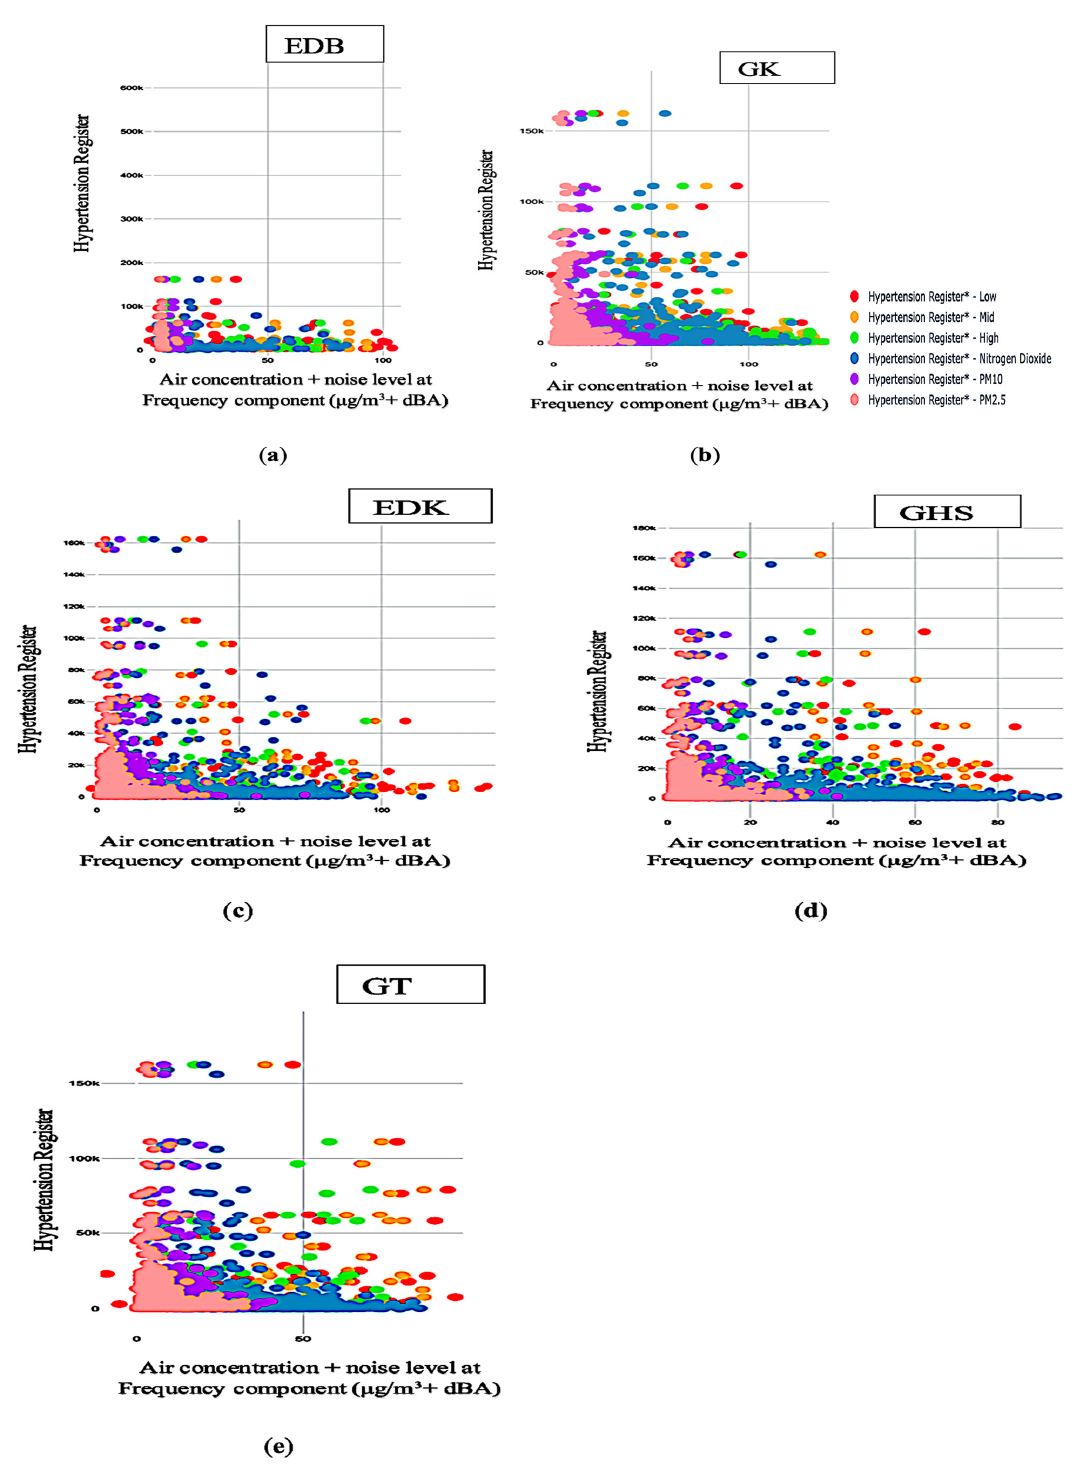
Figure 3. Relationship between joint air concentration and noise level at different frequency com- ponent range and registered hypertension cases at the five monitoring sites: ( a ) Joint air-noise pollution (dBA)/( µ g/m 3 ) with registered hypertension cases at EDB; ( b ) Joint air-noise pollution (dBA)/( µ g/m 3 ) with registered hypertension cases at GK; ( c ) Joint air-noise pollution (dBA)/( µ g/m 3 ) with registered hypertension cases at EDK; ( d ) Joint air- noise pollution (dBA)/( µ g/m 3 ) with reg- istered hypertension cases at GHS; ( e ) Joint air-noise pollution (Lden)/( µ g/m 3 ) with registered hypertension cases at